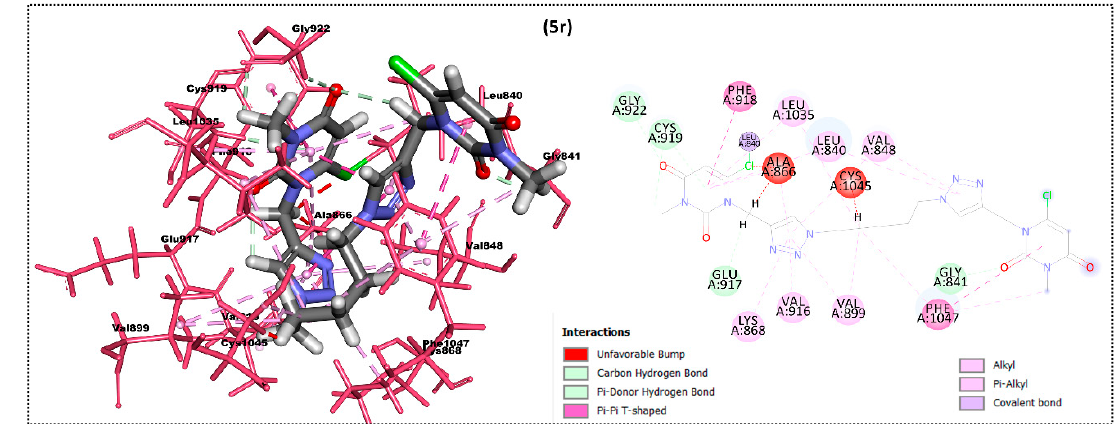
Figure 10. Docking interactions (3D & 2D) of 5r with the receptor protein, VEGFR-2 Transferase. Critical amino acid residues are shown in the stick model and pink colour.